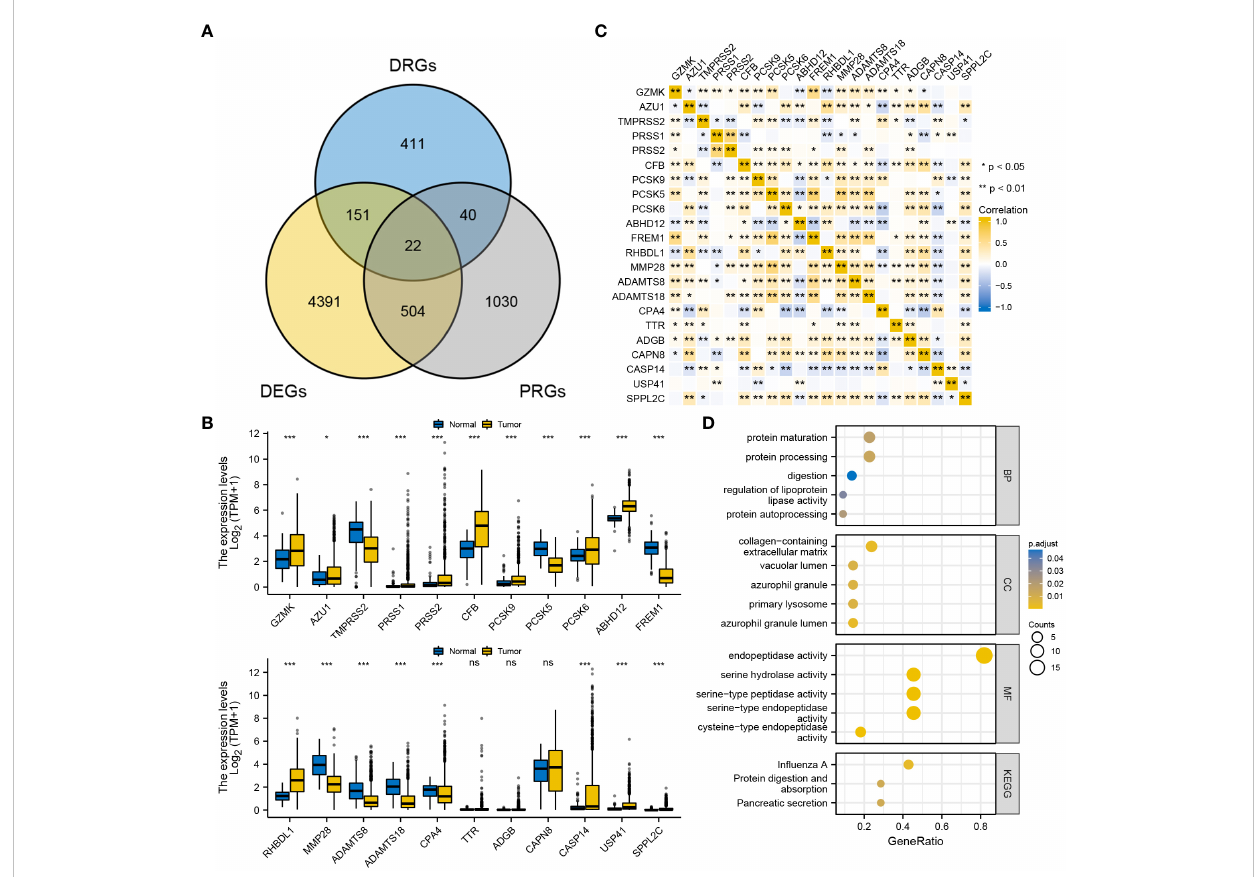
FIGURE 1 Primary identi fi cation and veri fi cation of DRGs in BRCA. (A) Intersection of DRGs, DEGs and PRGs. (B) Expression pattern of the 22 DRGs between BRCA and the normal. (C) Correlation among the expression of the 22 DRGs in BRCA. (D) GO/KEGG functional enrichment analyses of the 22 DRGs. ‘ *** ’ indicates P -value < 0.001. "ns" represents non-signi fi